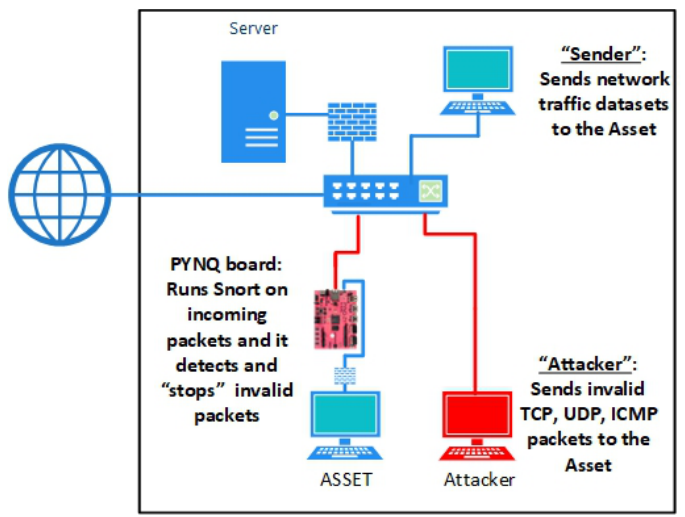
Figure 7. “Virtual” supply chain test